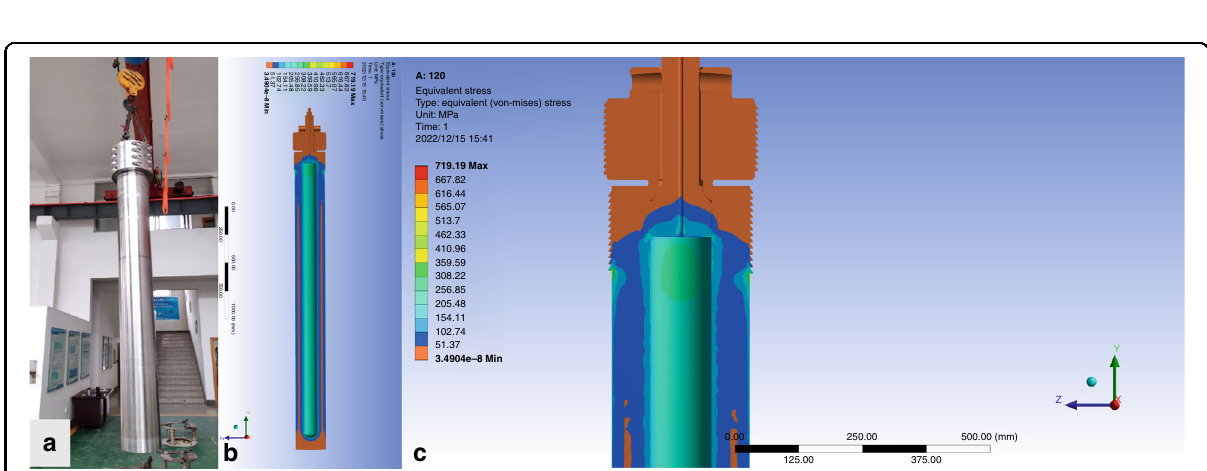
Fig. 5 Scale-up of autoclave and as-grown H-KTP in the past 46 years. The horizontal axis is the year, and the vertical axis is the inner diameter of the autoclave. The size of the crystal is largely determined by the inner diameter of the autoclave, so it is listed together in the graph, marked with a solid symbol to distinguish it from the hollow symbol representing the inner diameter of the autoclave. Due to the dif fi culty of equipment and technology, there are only a handful of institutional teams involved in hydrothermal growth of KTP after past 46 years